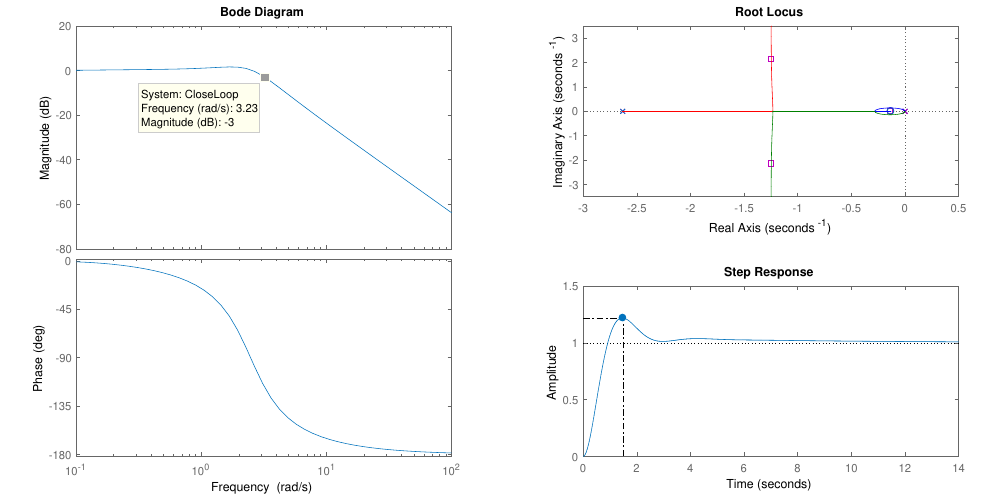
Figure 8. System characteristics with PI